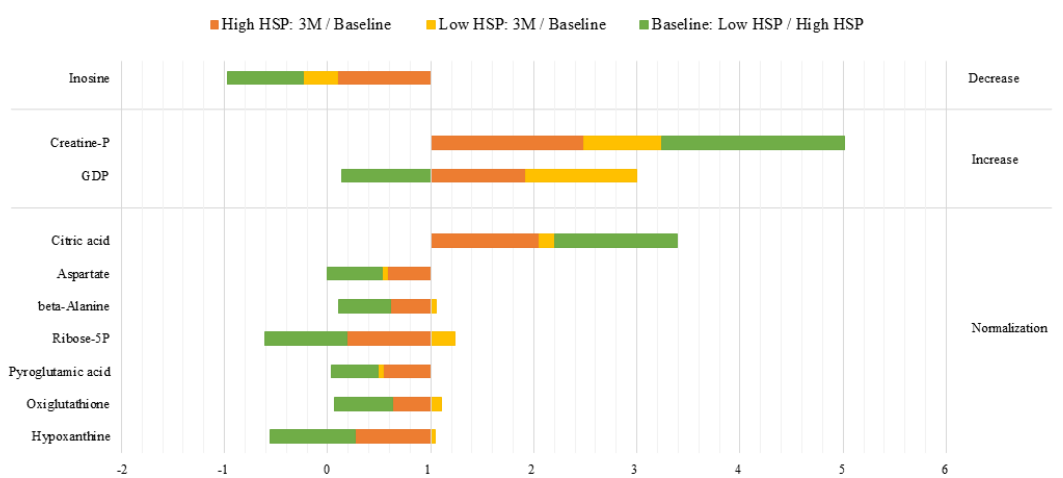
Figure 6. Metabolite ratios of high HSP: 3M/baseline, low HSP: 3M/baseline and baseline: low HSP/high HSP, grouped on behavior. Inosine showed simultaneous decrease (ratio < 0.667), whereas Creatine-P and GDP showed simultaneous increase (ratio > 1.5) in both high HSP: 3M/baseline and low HSP: 3M/baseline, representing the effect of L-glutamine supplementation on both. Seven metabolites (8.43%) showed a normalization behavior, in which high HSP: 3M/baseline shows a normalization (either increase or decrease) towards stable levels of low HSP: 3M/baseline.